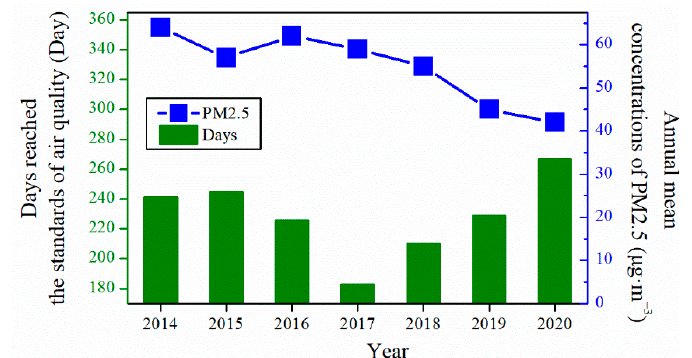
Figure 7. The number of days that reached the air quality standards in recent years and the annual mean concentrations of PM 2.5 in Jinzhong, Shanxi Province, China. mean concentrations of PM 2.5 in Jinzhong, Shanxi Province,